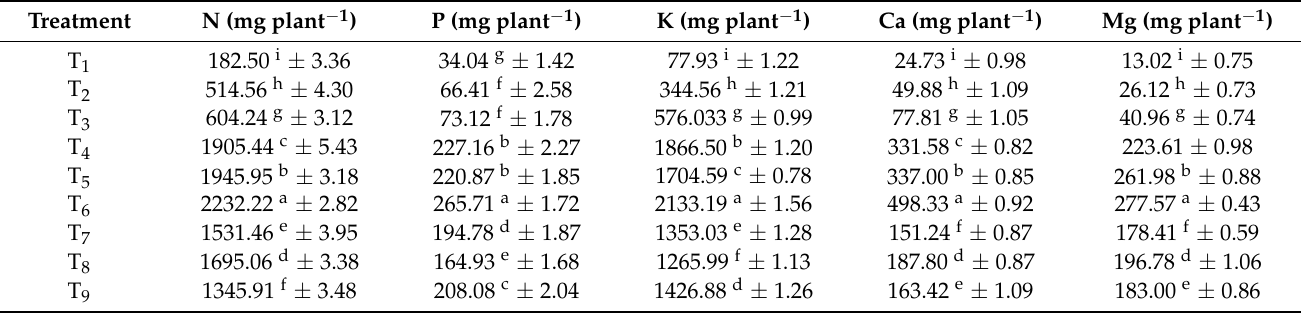
Table 5. Effect of treatments on maize plant nutrient